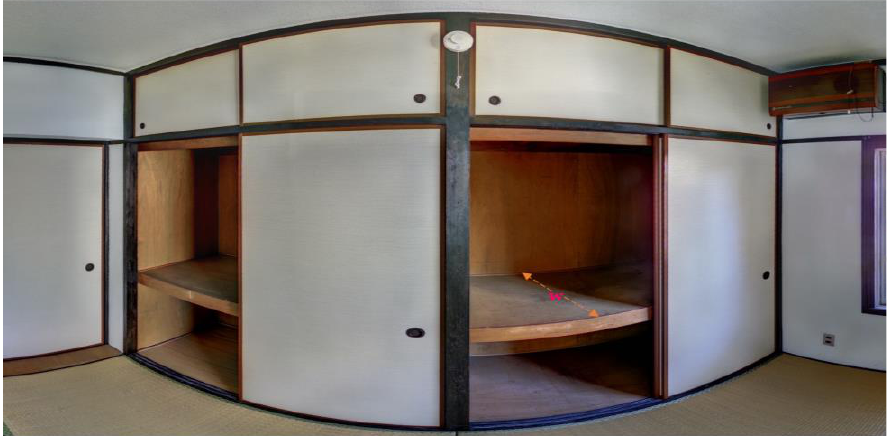
Figure 23. The wardrobe falsely detected as a wall.